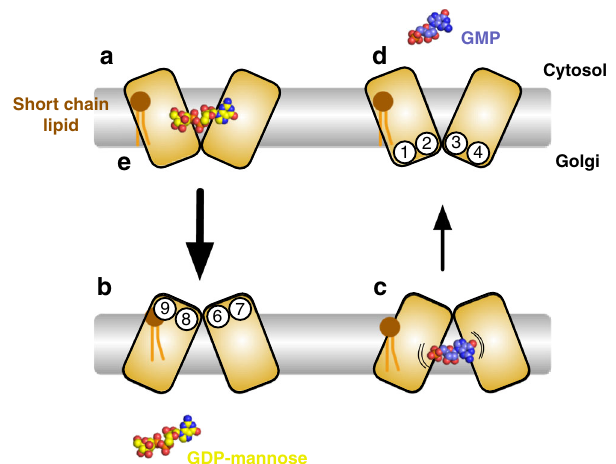
Fig. 6 Model of alternating access mechanism in Vrg4. a Vrg4 adopts an inward open state with the binding site orientated towards the